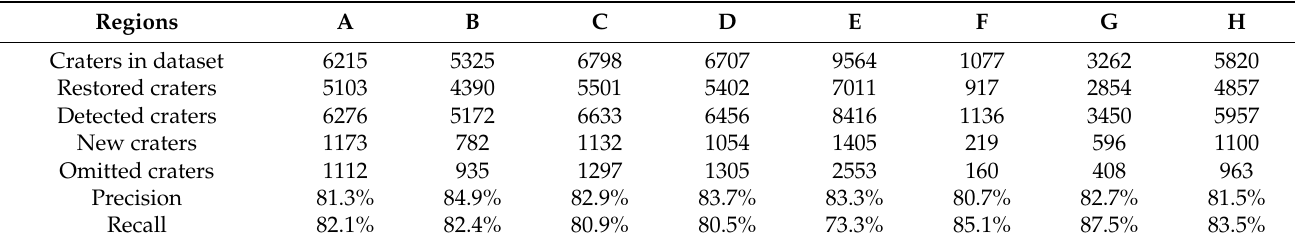
Table 6. Dual-Path test results in eight